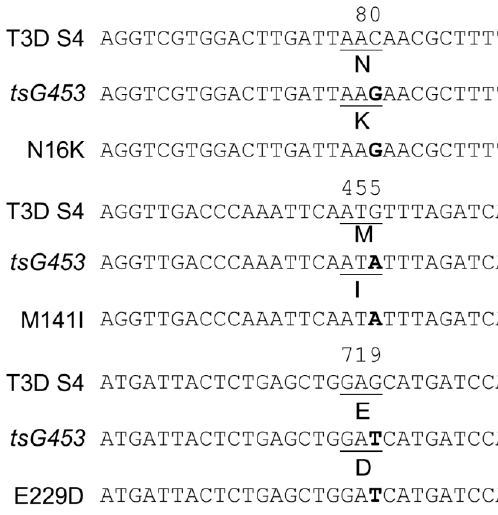
Figure 2. Sanger sequence confirmation of parental tsG453 and isolates containing each individual mutation. The top line depicts the wild-type T3D S4 nucleotide sequence and relevant σ3 amino acid residue. The second line depicts the corresponding sequence in the ts G453 mutant [36,37]. The bottom sequence line depicts the corresponding sequence in the indicated rescued isolate. Data for the T3D S2 gene ( tsC447 ) are not shown because only a single recombinant isolate sequence was recovered.